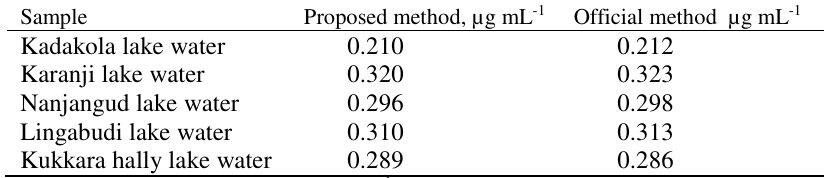
Table 1. Determination of hydrogen sulphide in water